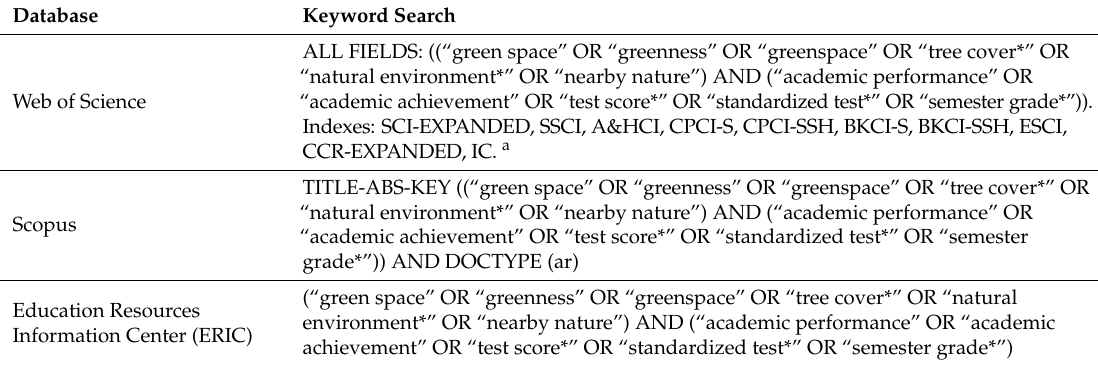
Table A1. Search expressions by database used in the review.